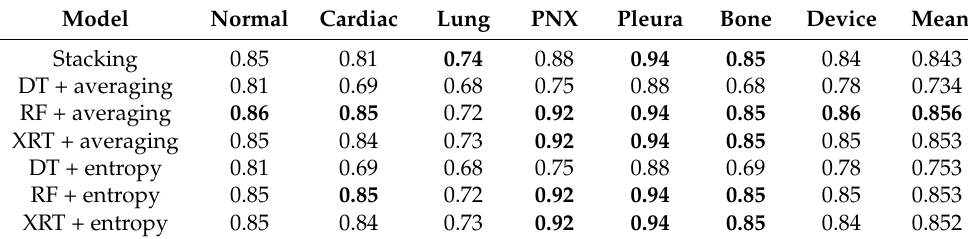
Table 6. Results of stacking and tree-based models trained on embeddings extracted from pretrained CNNs in terms of AUC. Each column represents an HUM-CXR finding. We report the results for each tree model and for both ensembling strategies. Best results for each class and average are highlighted in bold.